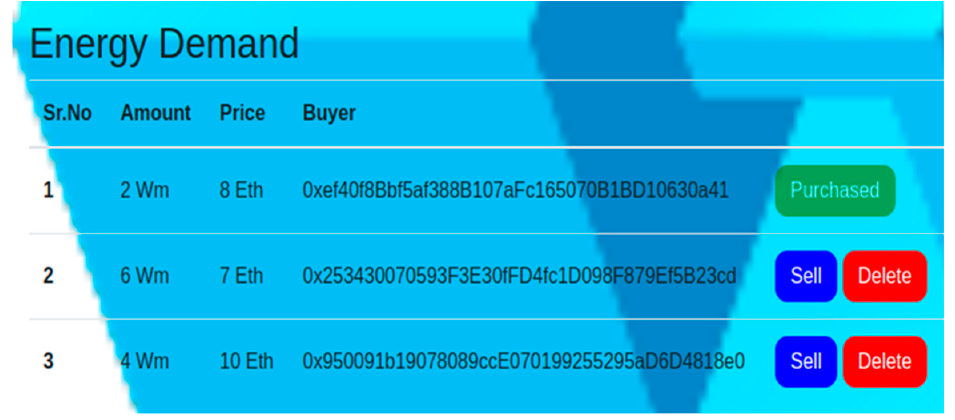
Figure 16. Transaction details on the blockchain.